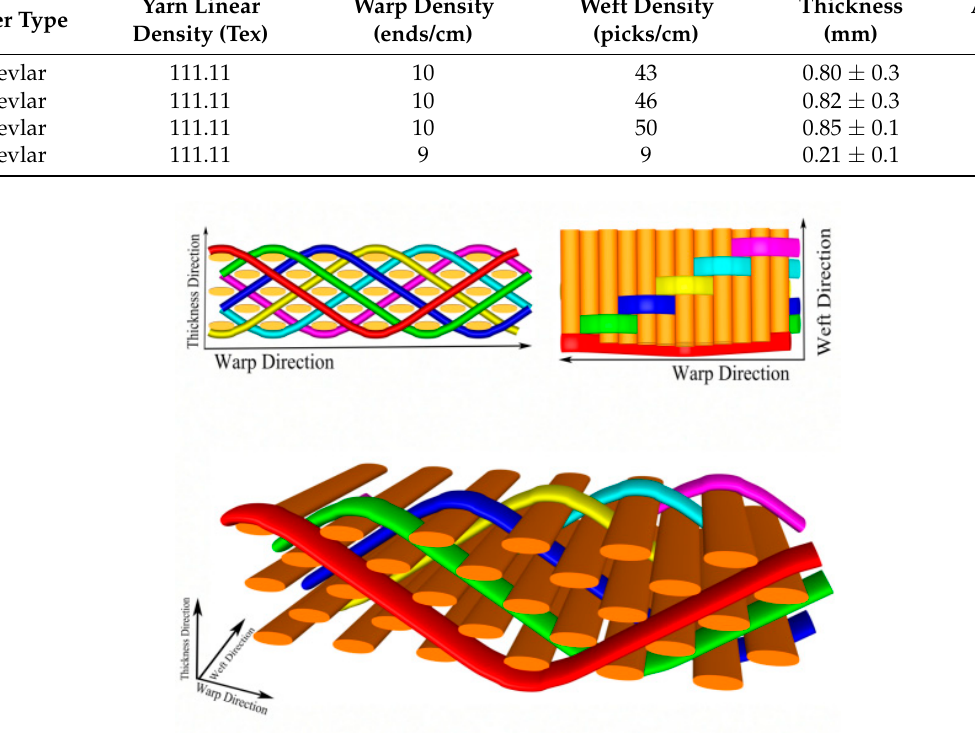
( b ) Figure 2. The bending stress-strain curve of 3DDAI Kevlar/EP armor materials with different stack- ing layers. ( a ) The warp direction. ( b ) The weft direction. ( a ) ( b ) Figure 3. Bending failure morphologies of 3DDAI of Kevlar/EP armor materials with 1 to 2 layers. ( a ) 1 layer. ( b ) 2 layer.